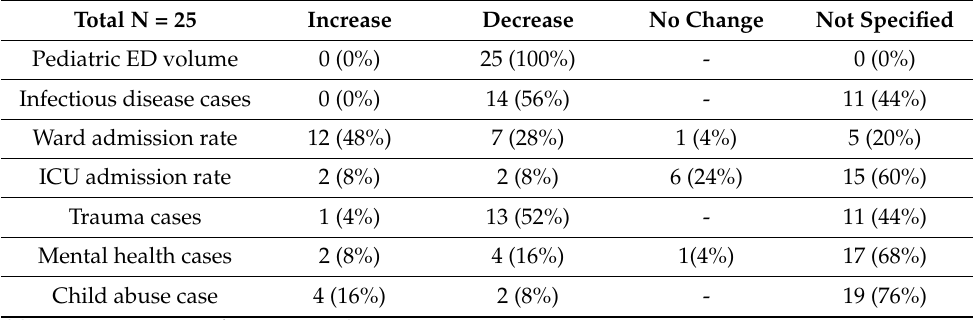
Table 2. Summarized effects of COVID-19 on pediatric emergency department.